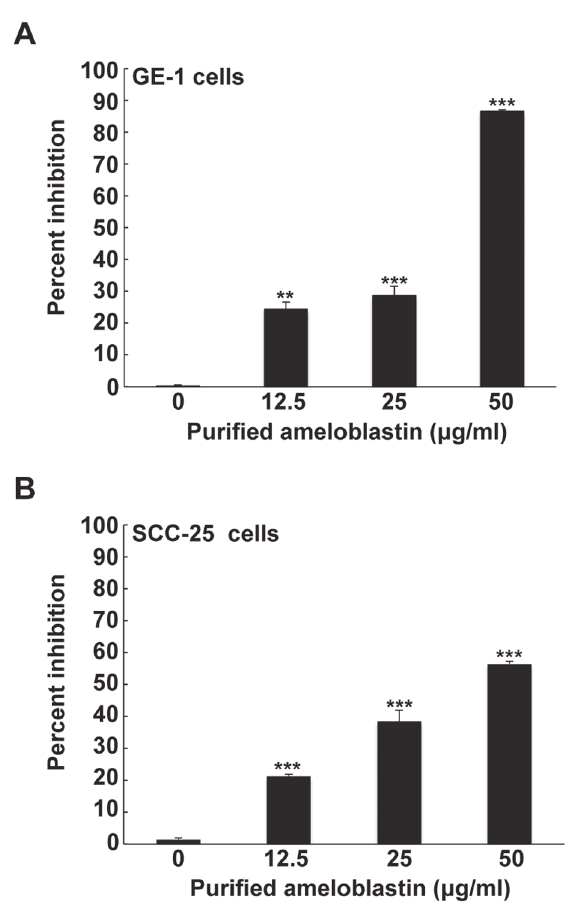
Figure 4- Effects of recombinant ameloblastin on epithelial cell proliferation. GE-1 (A) and SCC-25 (B) cells were separately stimulated with recombinant ameloblastin protein for 48 hours, after which cell viability was determined using WST-1 analysis. The data shows the percent inhibition of cell proliferation from independent samples (n=3). The bars represent mean±standard deviation. Data was analyzed by Dunnett’s test after one- way ANOVA (**P<0.01, ***P<0.0001 vs untreated